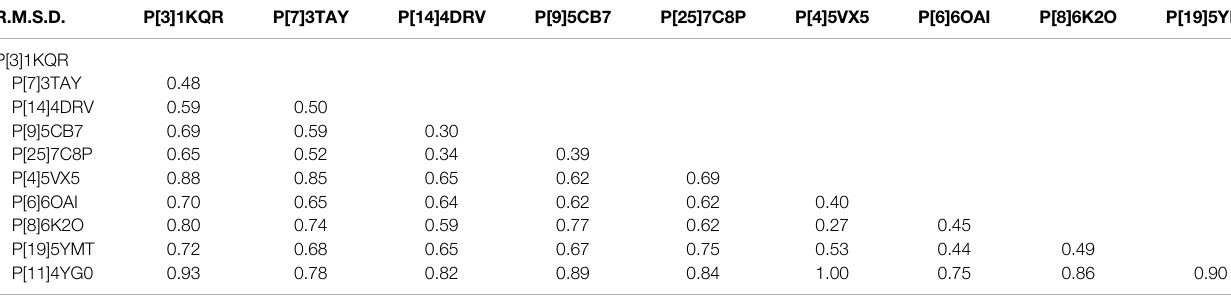
TABLE 1 | The RMSDs (in Å) of the C α atoms of VP8* monomer between different P genotypes. R.M.S.D.